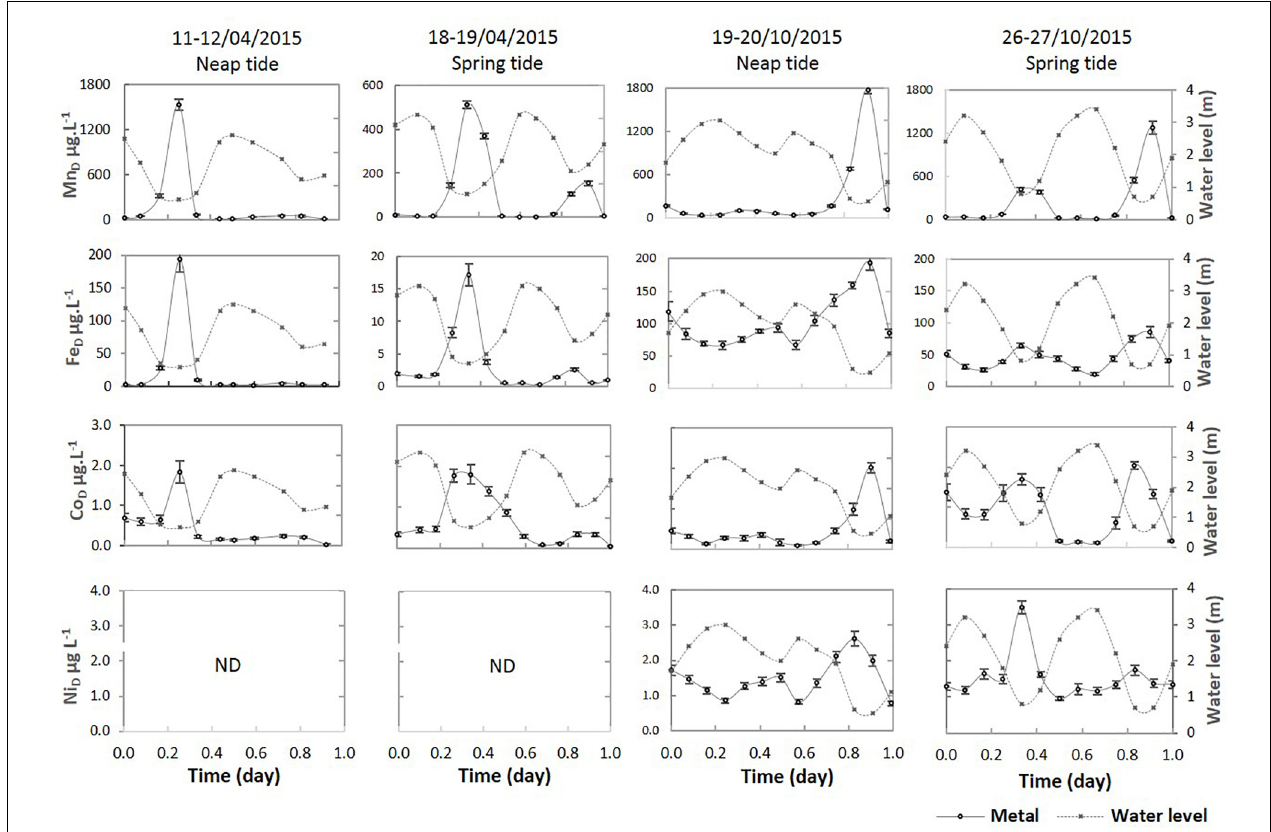
FIGURE 3 | Temporal fluctuations of dissolved metal concentrations (M D ) during the neap and the spring tidal cycles during the dry season (04/2015) and the wet season (10/2015). ND: not